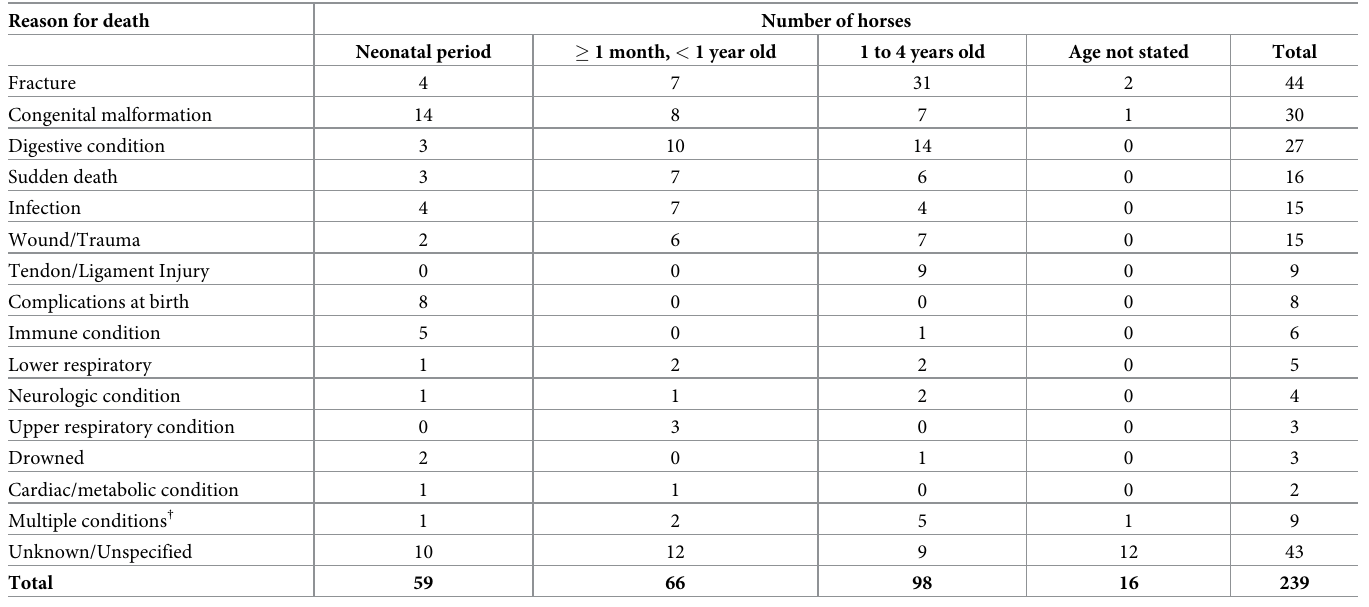
Table 2. Age distribution and reasons for death of horses.